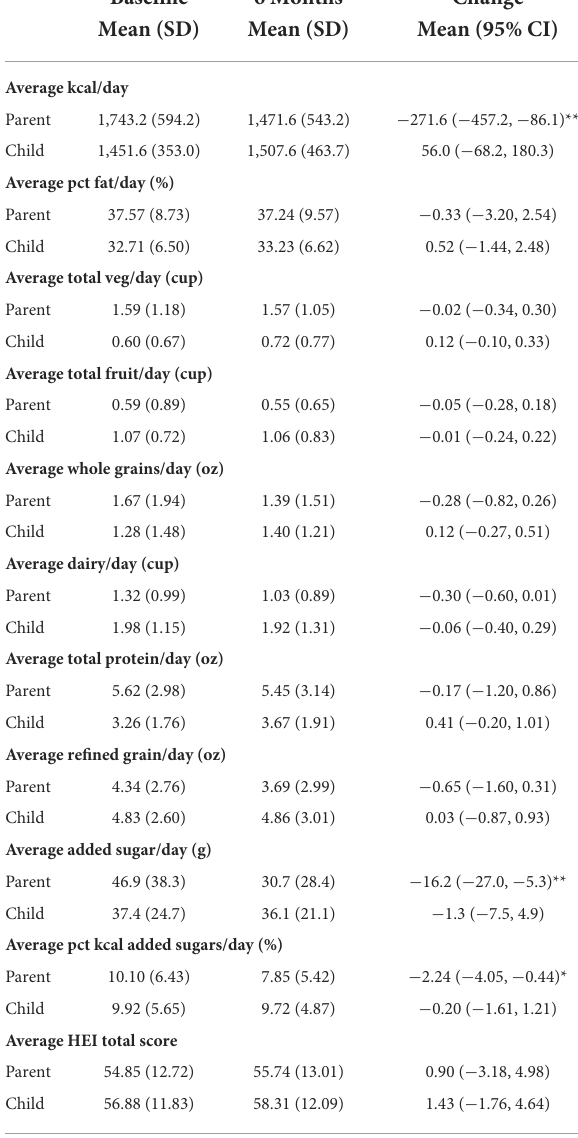
TABLE 2 Means and standard deviations of dietary component variables for n = 66 parents and children with dietary data at both time